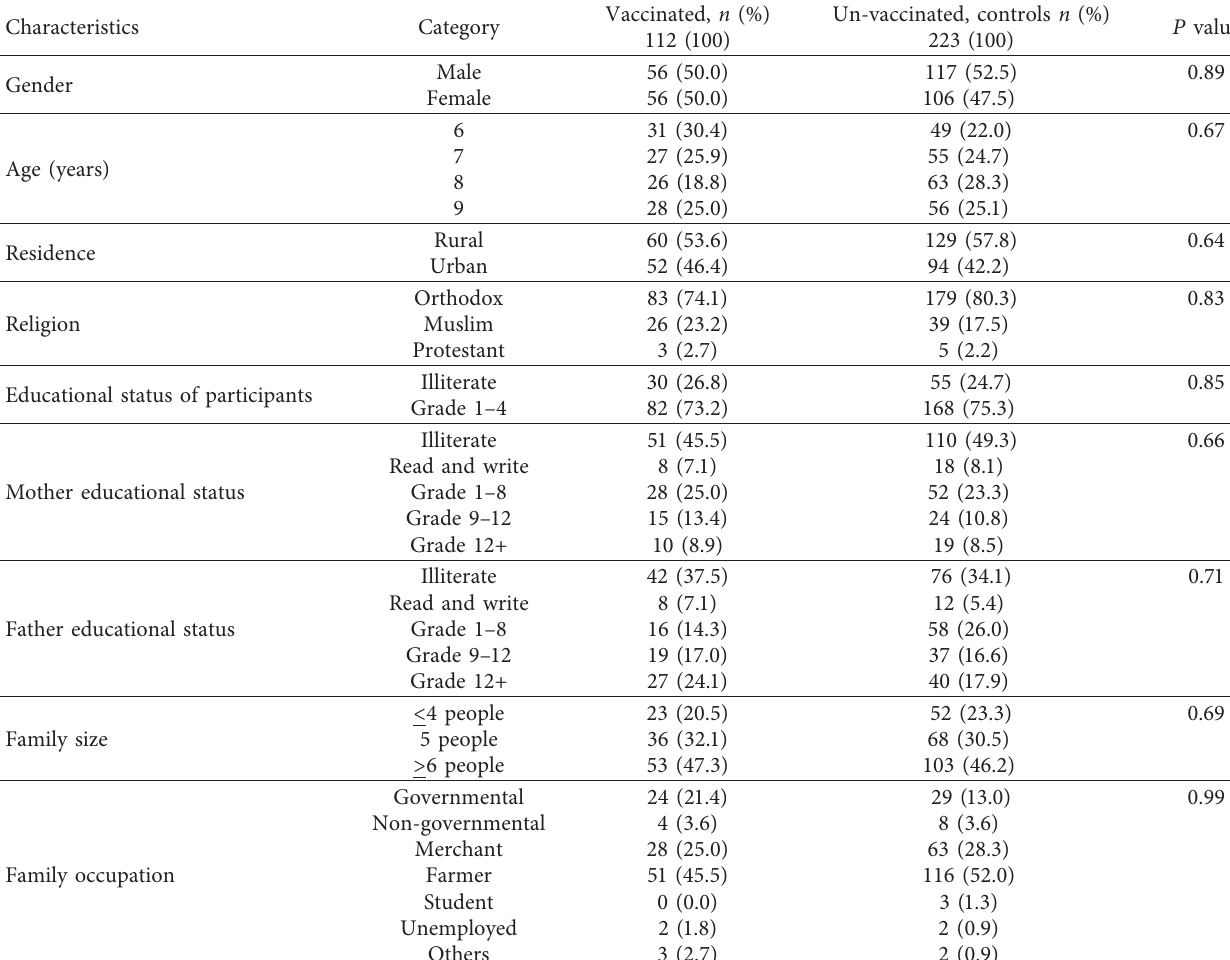
Table 1: Socio-demographic characteristics of vaccinated and un-vaccinated controls, matched by age, Amhara Regional State, Ethiopia, 2019.